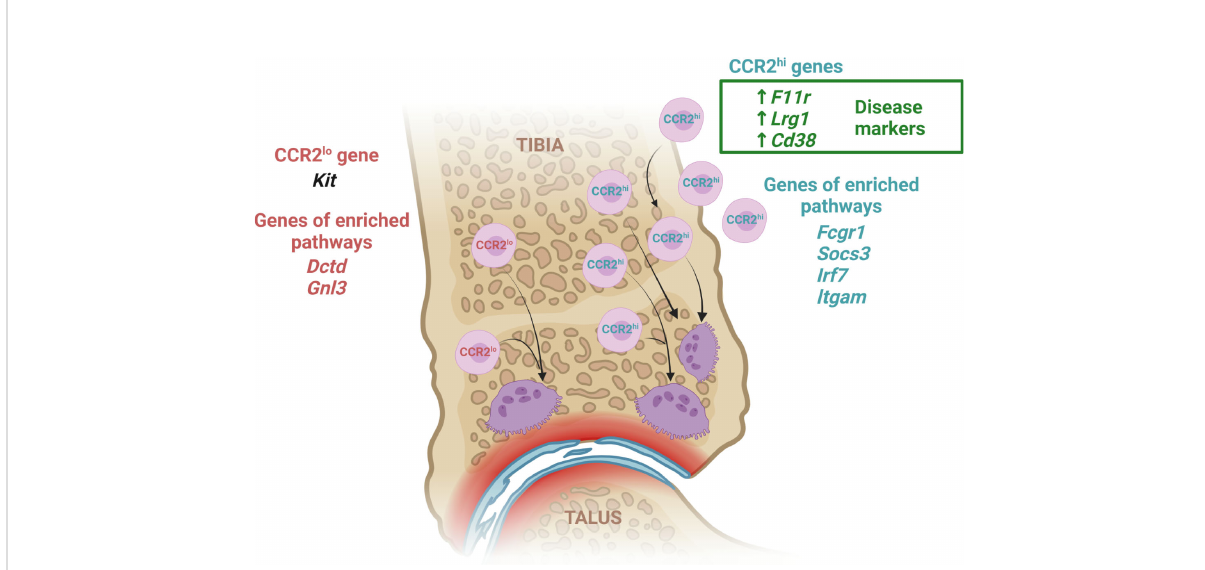
FIGURE 8 Transcriptome response of CCR2 hi and CCR2 lo osteoclast progenitor (OCP) subsets to arthritis. To better reveal the biology of in fl ammatory osteoresorption, we assessed the transcriptome pro fi le of two distinct subsets of OCPs categorized by the level of CCR2 expression. We identi fi ed several genes involved in cell adhesion and migration ( F11r , Cd38 , Lrg1 ), which could be considered arthritis-speci fi c genes of CCR2 hi subset due to being more expressed in arthritic compared to control mice and exhibiting a positive correlation between expression level